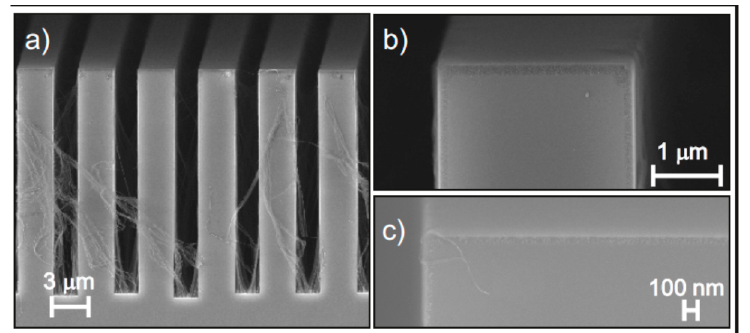
Figure 6. SEM in cross-section of Pt assisted chemical etching of silicon grating with 4.8 µm pitch ( a , c ), magnified view of the top ( b ) with etching solution ρ (HF) = 0.99 20 . Magnified view of top ( c ) with additional methanol in the etching solution. The figure was adapted with permission from L. Romano